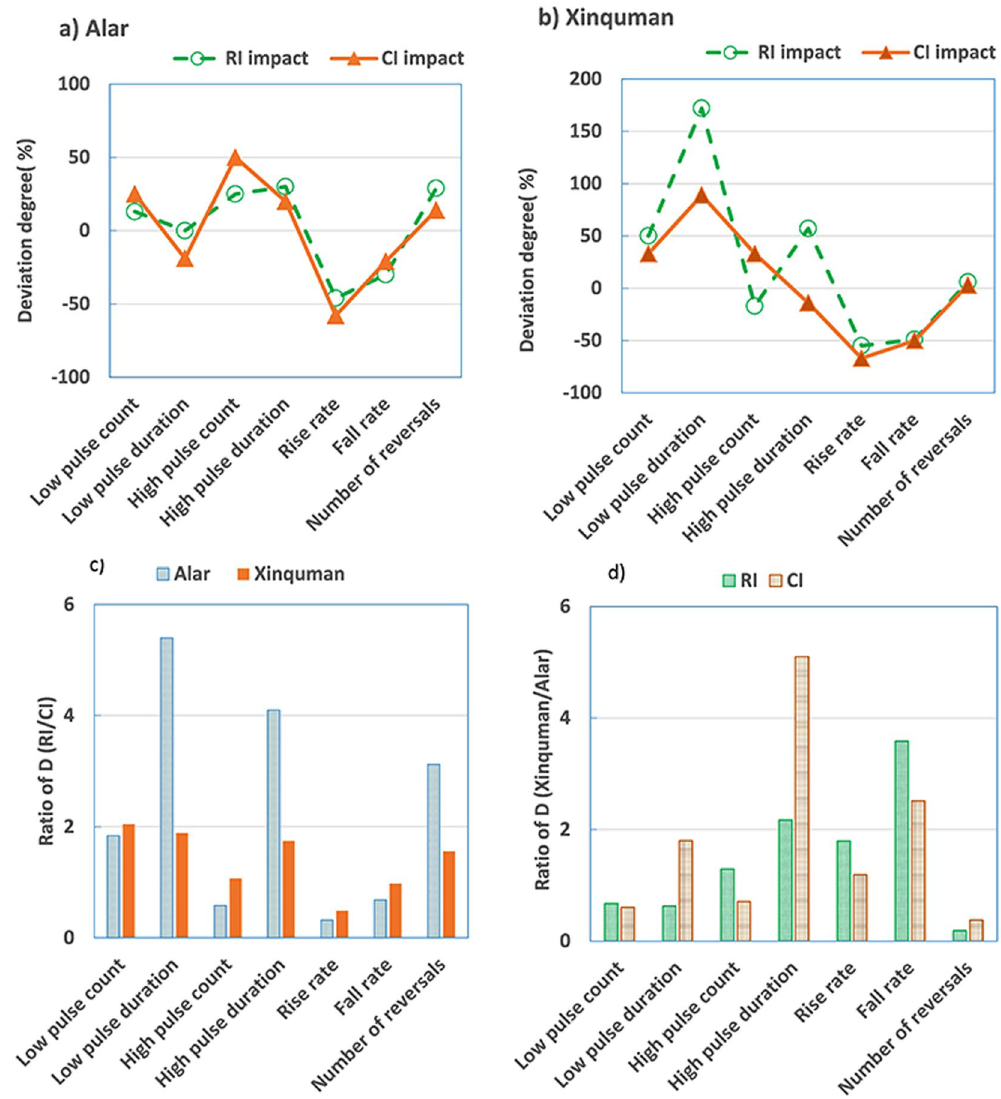
Figure 4. Plots of deviation degree of IHAs in Groups 4 and 5 at ( a ) the Alar station and ( b ) the Xinquman station, and ratio of degree of hydraulic alteration for ( c ) the RI impact to the CI impact and ( d ) the Alar station to the Xinquman station (note: RI for reservoir irrigation from 1973 to 1989 and CI for channel irrigation from 1995 to